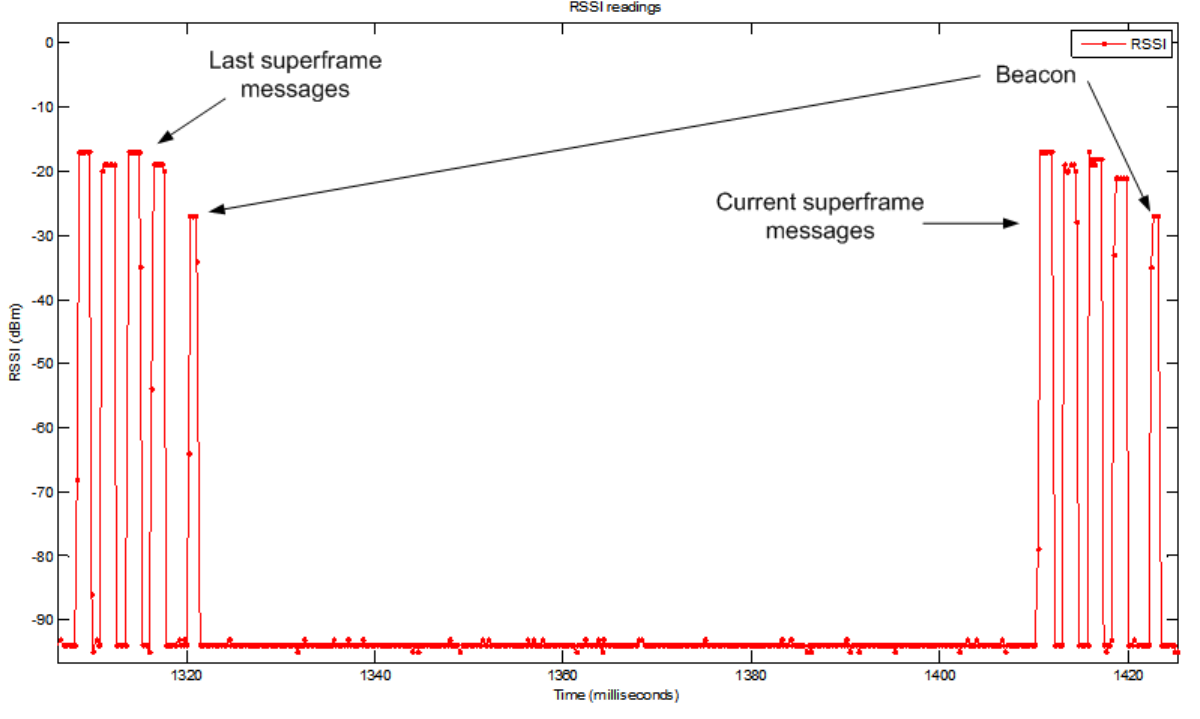
Figure 13. Transmissions of four sensor nodes in the